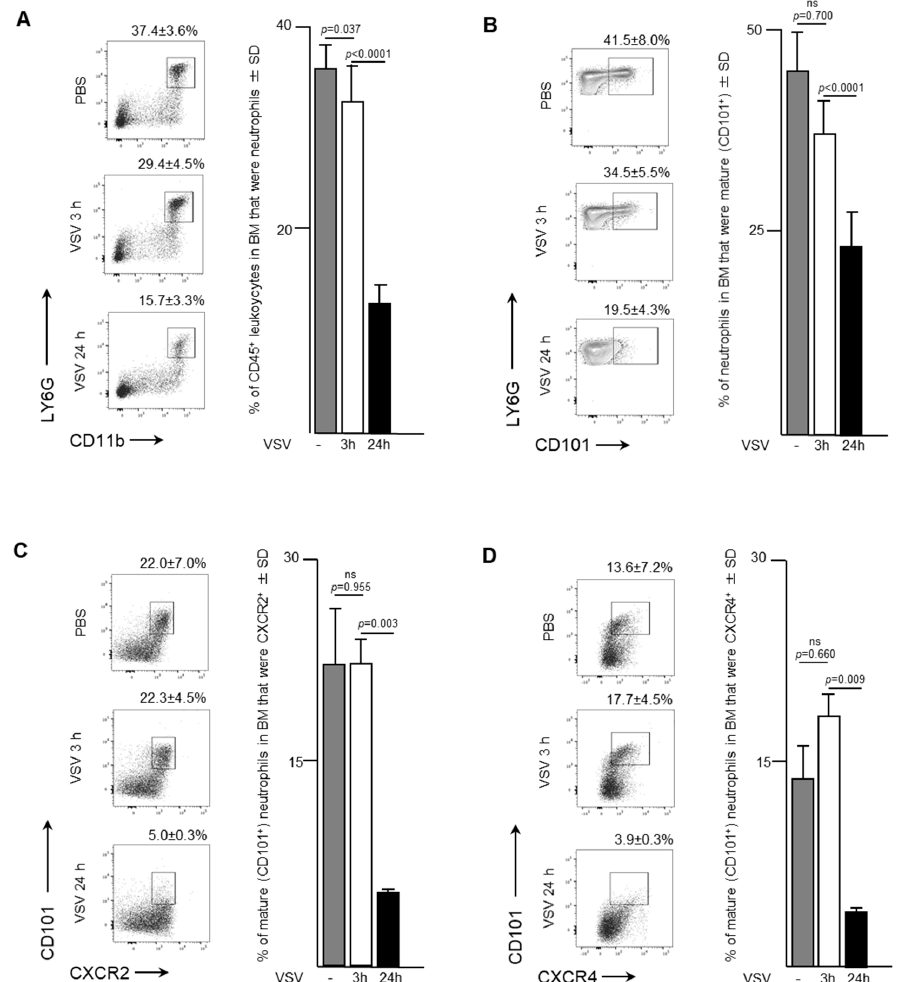
Figure 1. Neutrophils rapidly emigrated from bone marrow in response to infection with vesicular stomatitis virus (VSV). Six- to eight-week-old female C57BL / 6 mice were injected intravenously with 1 × 10 9 plaque-forming units of VSV or phosphate-bu ff ed saline (PBS) and euthanized three- or 24-hours (h) later. Bone marrow flushed from femurs was used to quantify neutrophils by flow cytometry. Representative dot plots and graphs with means and standard deviations (SD) ( n = 8 / group) are shown for percentages of ( A ) CD45 + leukocytes that were neutrophils (defined as CD45 + Ly6G hi CD11b hi ), ( B ) neutrophils that were mature (defined by the additional expression of CD101), and ( C , D ) mature neutrophils expressing the lung-homing chemokine receptors ( C ) CXCR2 or ( D ) CXCR4. Data were assessed by one-way analysis of variance with Tukey’s multiple comparisons test. (ns = not significantly different).